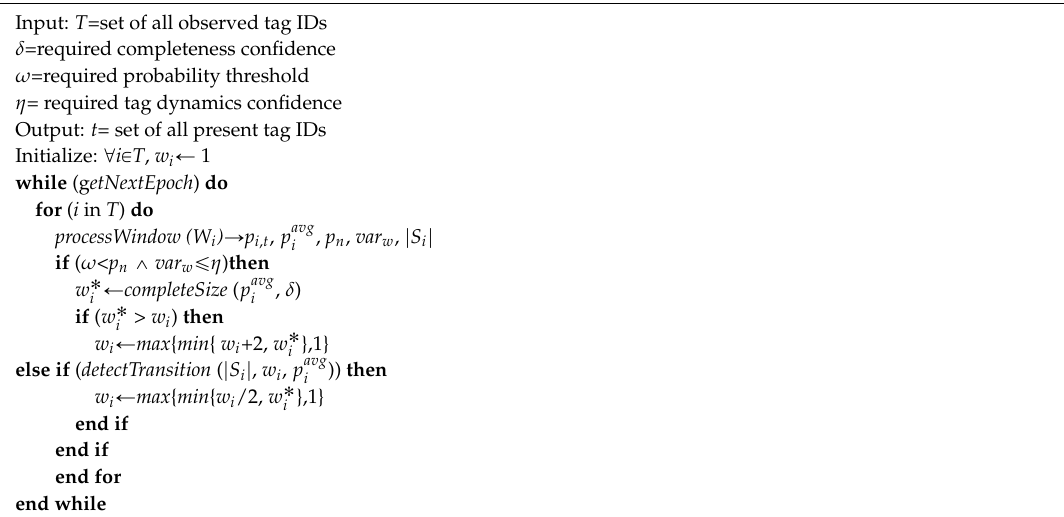
Algorithm 1. This method dynamically adjusts its window size for each tag, based on the guidance from its binomial-sampling model as discussed above with parameter δ , ω and η . Algorithm 1. Synthetic per-tag data cleaning